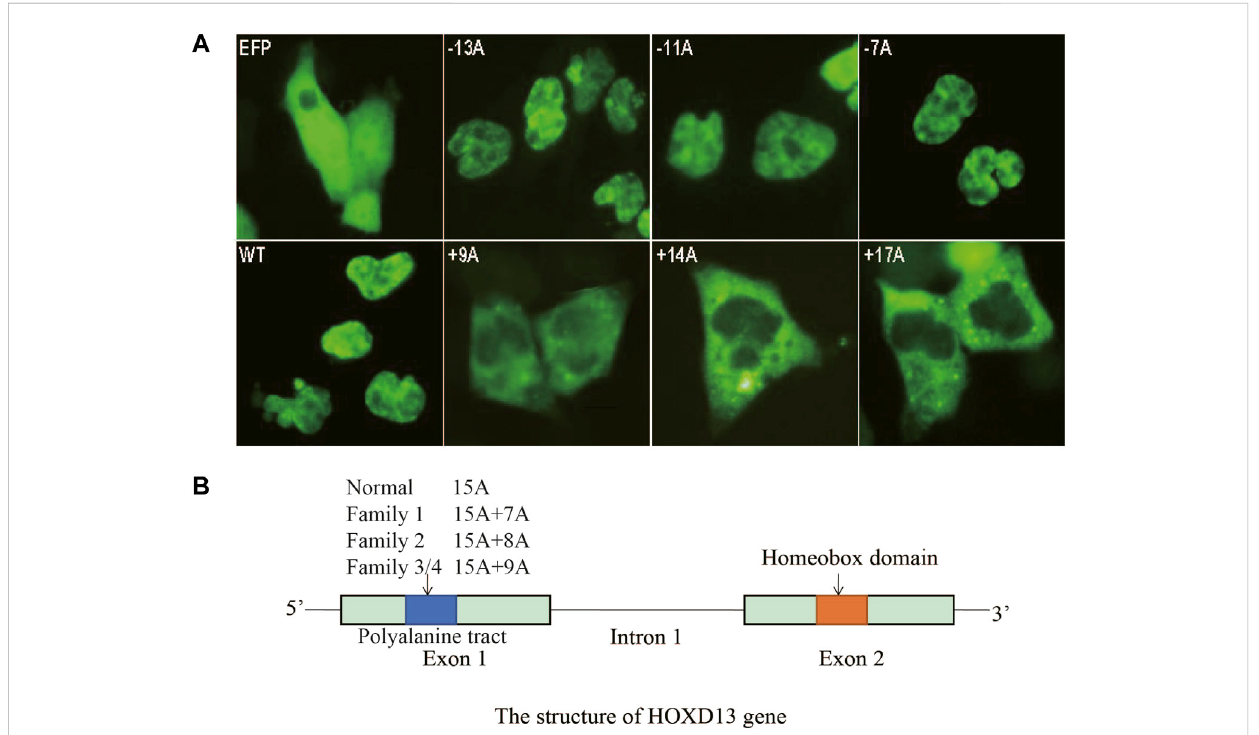
FIGURE 4 CellularlocalizationofthefusionproteinofGFP-HOXD13inCOS-7cells. (A) Expressionofeightvectors:GFP,pEGFP-C3vector;WT,thepEGFP-C3 with wild type HOXD13; three HOXD13 poly-Ala mutant plasmids with polyalanine contractions (PACs) ( − 13A, − 11A and -7A); three HOXD13 poly-Ala mutant plasmids with polyalanine expansions (PAEs) (+9A, +14A, and +17A). The wild type and the PAC mutant of HOXD13 did not affect the cellular localization ofthefusionprotein,butthePAEofHOXD13causedtheaggregationoffusionproteinsinthecytoplasm.Moreover,withtheincreaseof PAE, the inclusion body of fusion protein in cytoplasm increased. (B) Schematic structure of HOXD13 , the polyalanine tract located in the fi rst exon and the homeobox domain located in the second